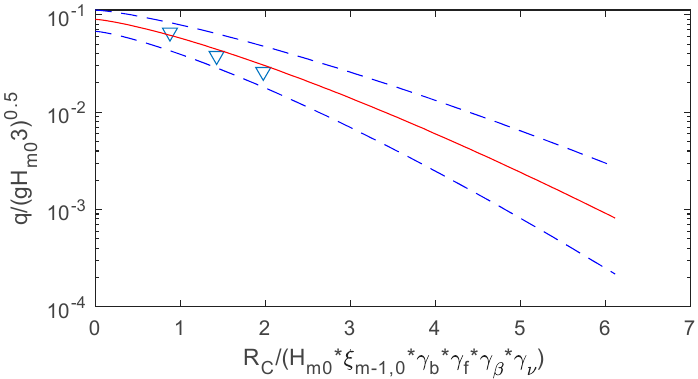
Figure 9. Comparison to Altomare [5] (red solid line: prediction using mean value approach of Altomare; dashed line: ± 1.64 σ ; and triangle: SWASH